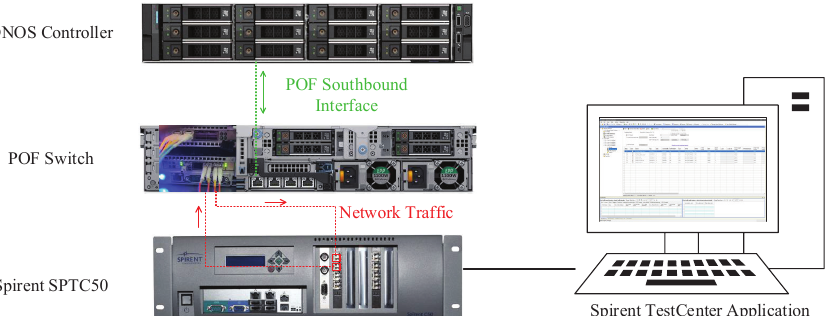
Figure 9. The setup of the